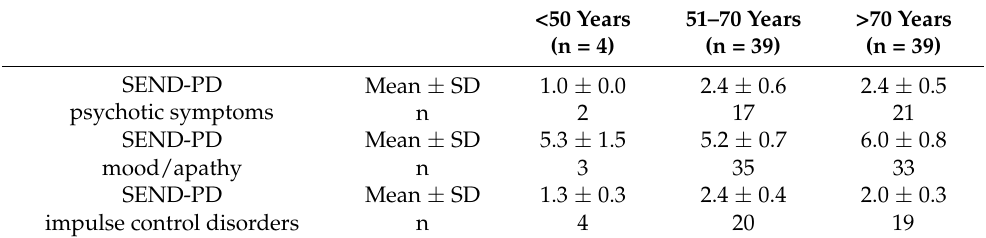
Table A2. Numbers of PwP and neuropsychiatric symptoms depending on